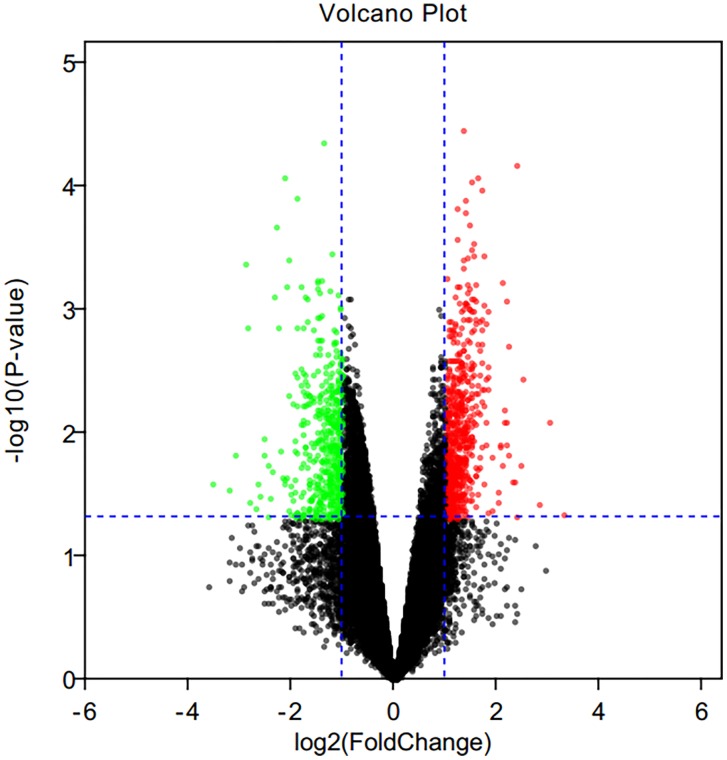
Volcano plot of differential expression genes. Red points as up-regulated genes, green plots as down-regulated genes, and black plots as genes with no significant difference.